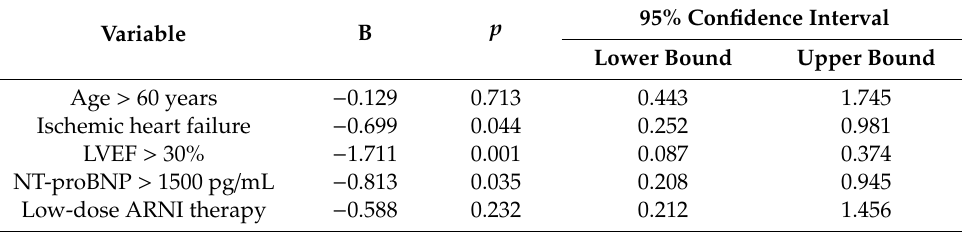
Table 3. Multivariable analysis of predictors of response to ARNI